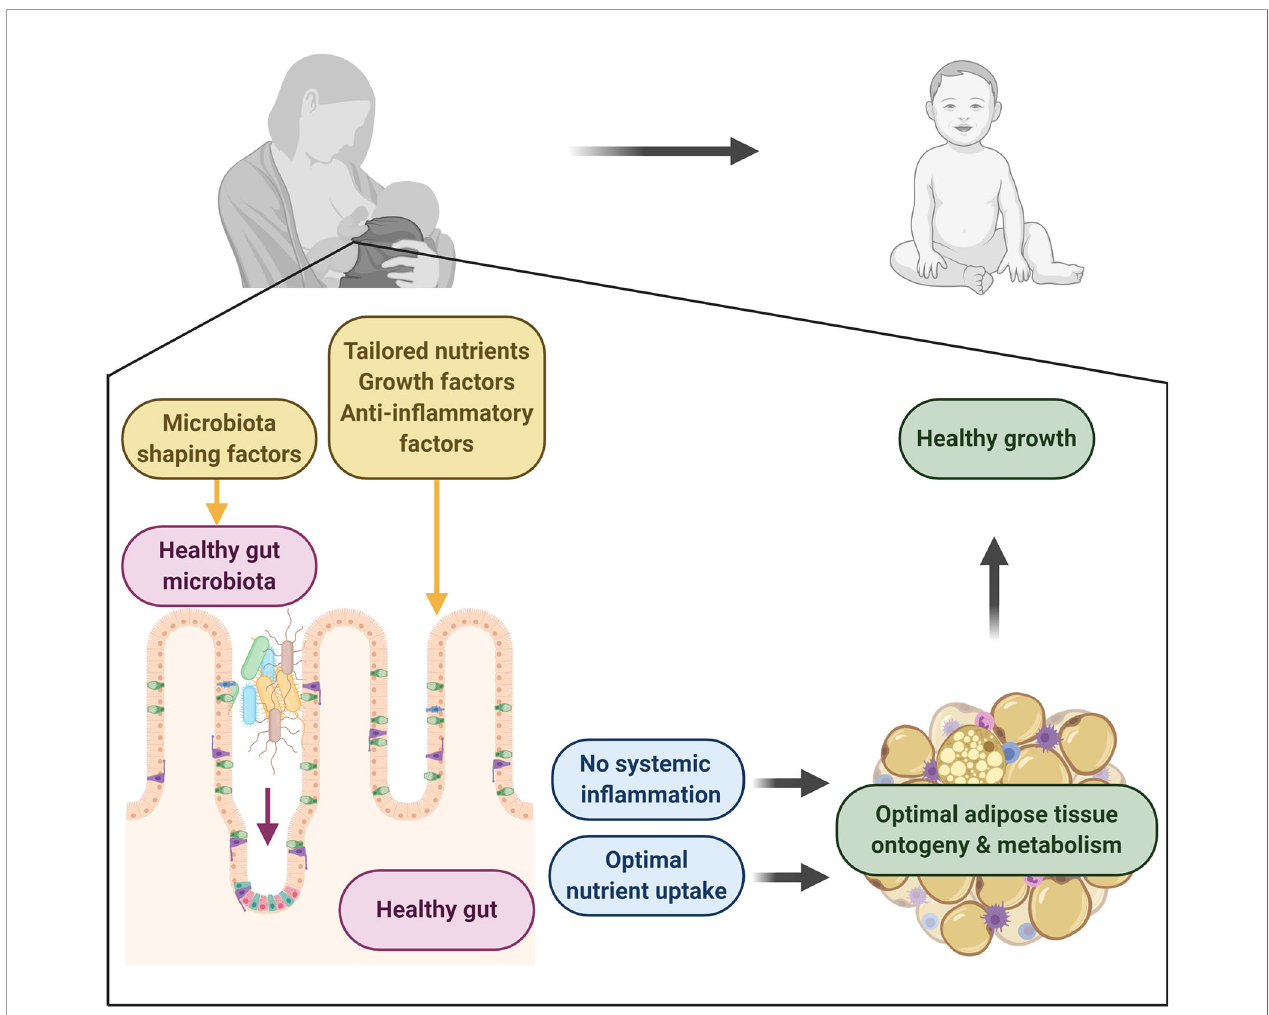
FIGURE 1 | Human milk directs healthy adipose tissue development and growth. Human milk contains a plethora of factors with the potential to drive healthy development. It contains key macro- and micronutrients for the neonate to develop and thrive. It also provides important factors for the development of a healthy gut, which forms a selective immune barrier with the capacity to take up nutrients and control systemic in fl ammation. Microbiota-shaping factors in milk aid in the establishment of a healthy gut microbiota which contributes to healthy gut development and which regulatory metabolites can circulate, protecting from in fl ammation. Together this will lead to healthy adipose tissue development, leading to optimal growth in infants. Figure created with